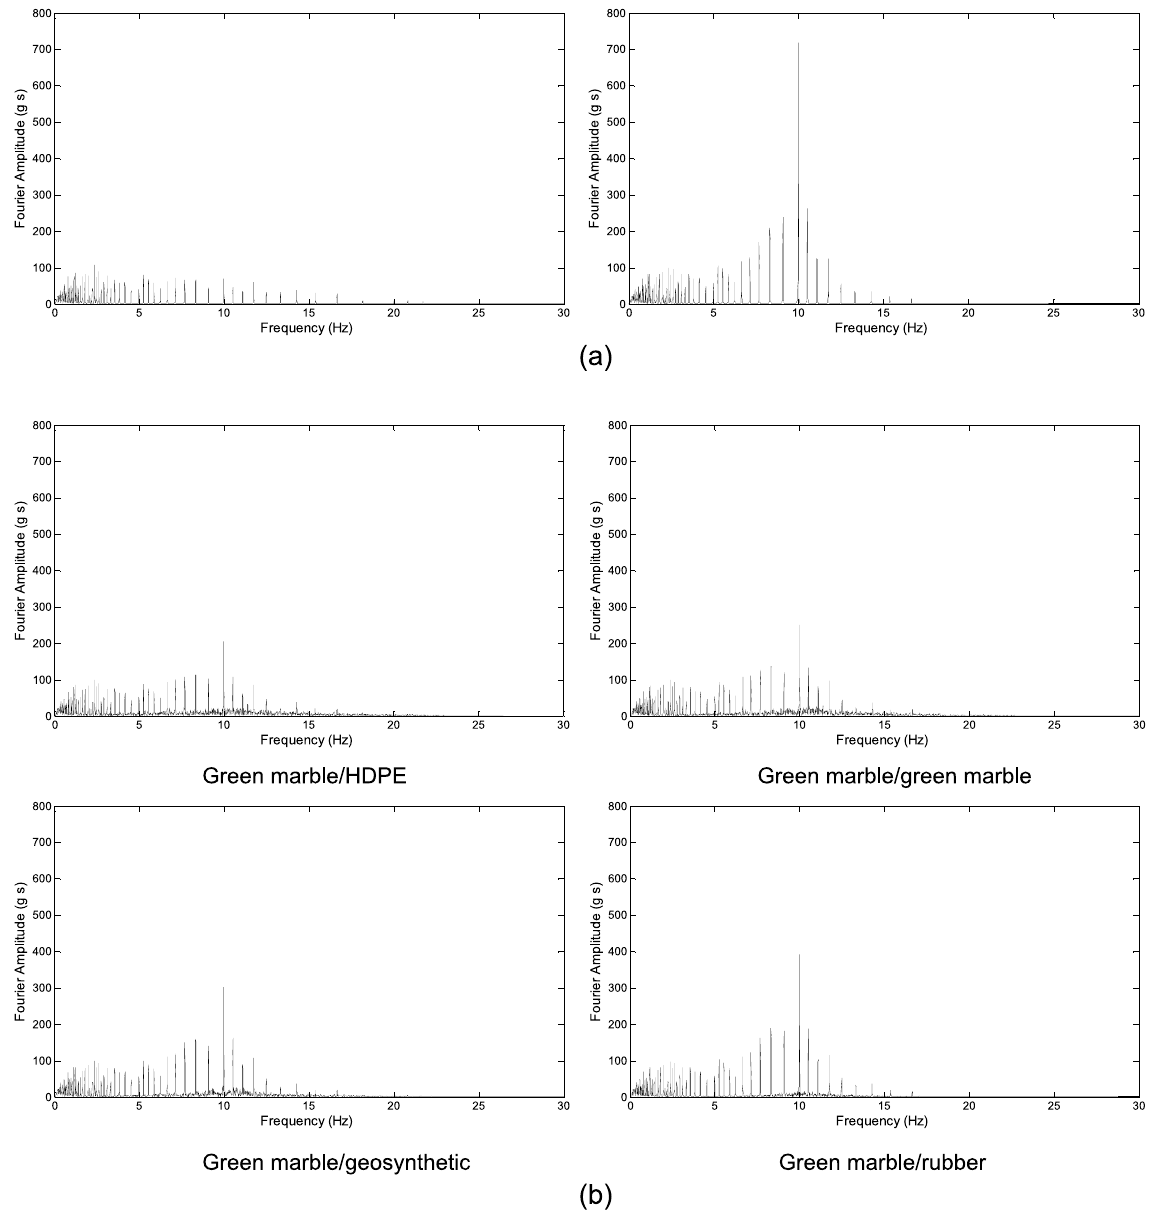
Fig. 9. a) Smooth Fourier amplitude spectra of ground acceleration (left) and corresponding absolute response acceleration of roof mass (right) of fi xed base building. b) Smooth Fourier amplitude spectra of absolute response acceleration of roof mass for different sliding interfaces buildings. 1. The 28 June 1992 Landers earthquake recorded at Joshua Tree, CA, Fire Station (CSMIP station 22170) 10 km from the fault, Component: 90, with 0.28 g